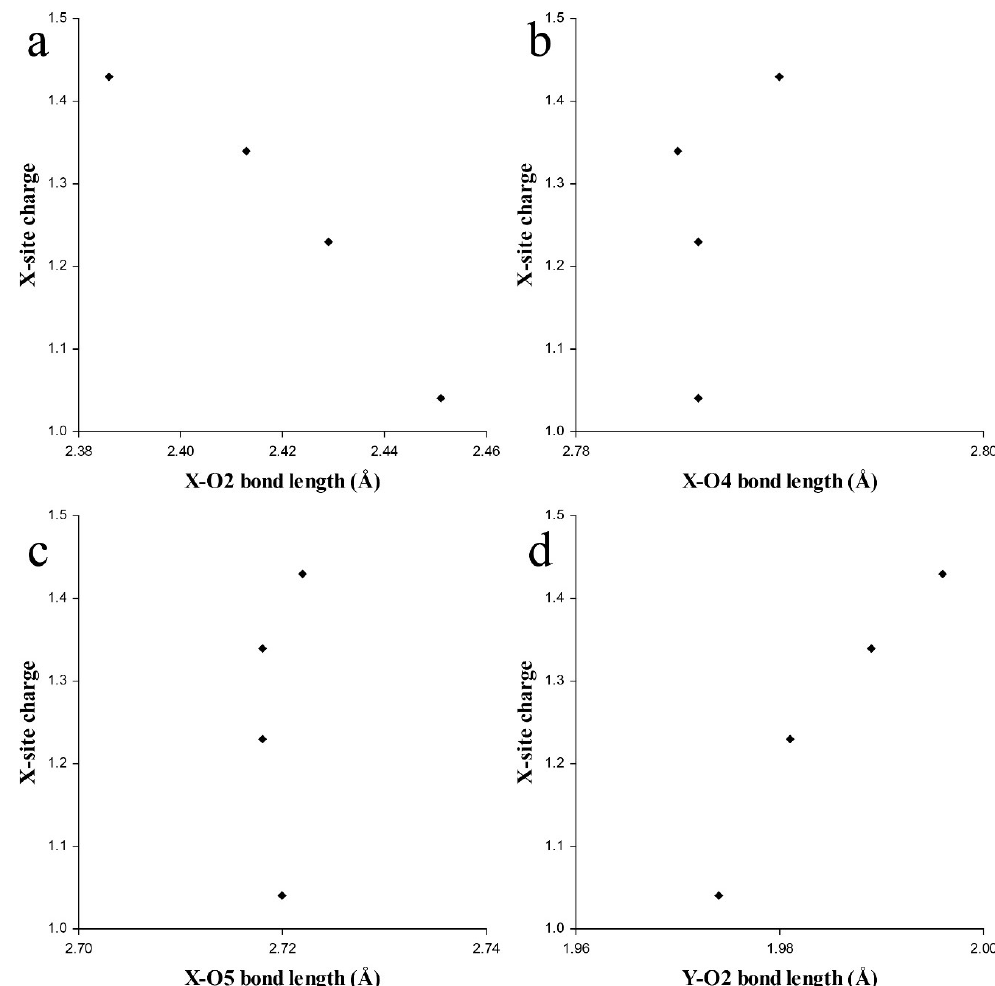
Figure 9. Correlation between the average X-site charge (Na 1 + , Ca 2 + , K 1 + ) to ( a ) X–O2, ( b ) X–O4, (c) X–O5 and ( d ) Y-O2 bond lengths in tourmalines with varying fluor-elbaite and fluor-liddicoatite components [52]. The standard deviation of the bond lengths is within the size of the